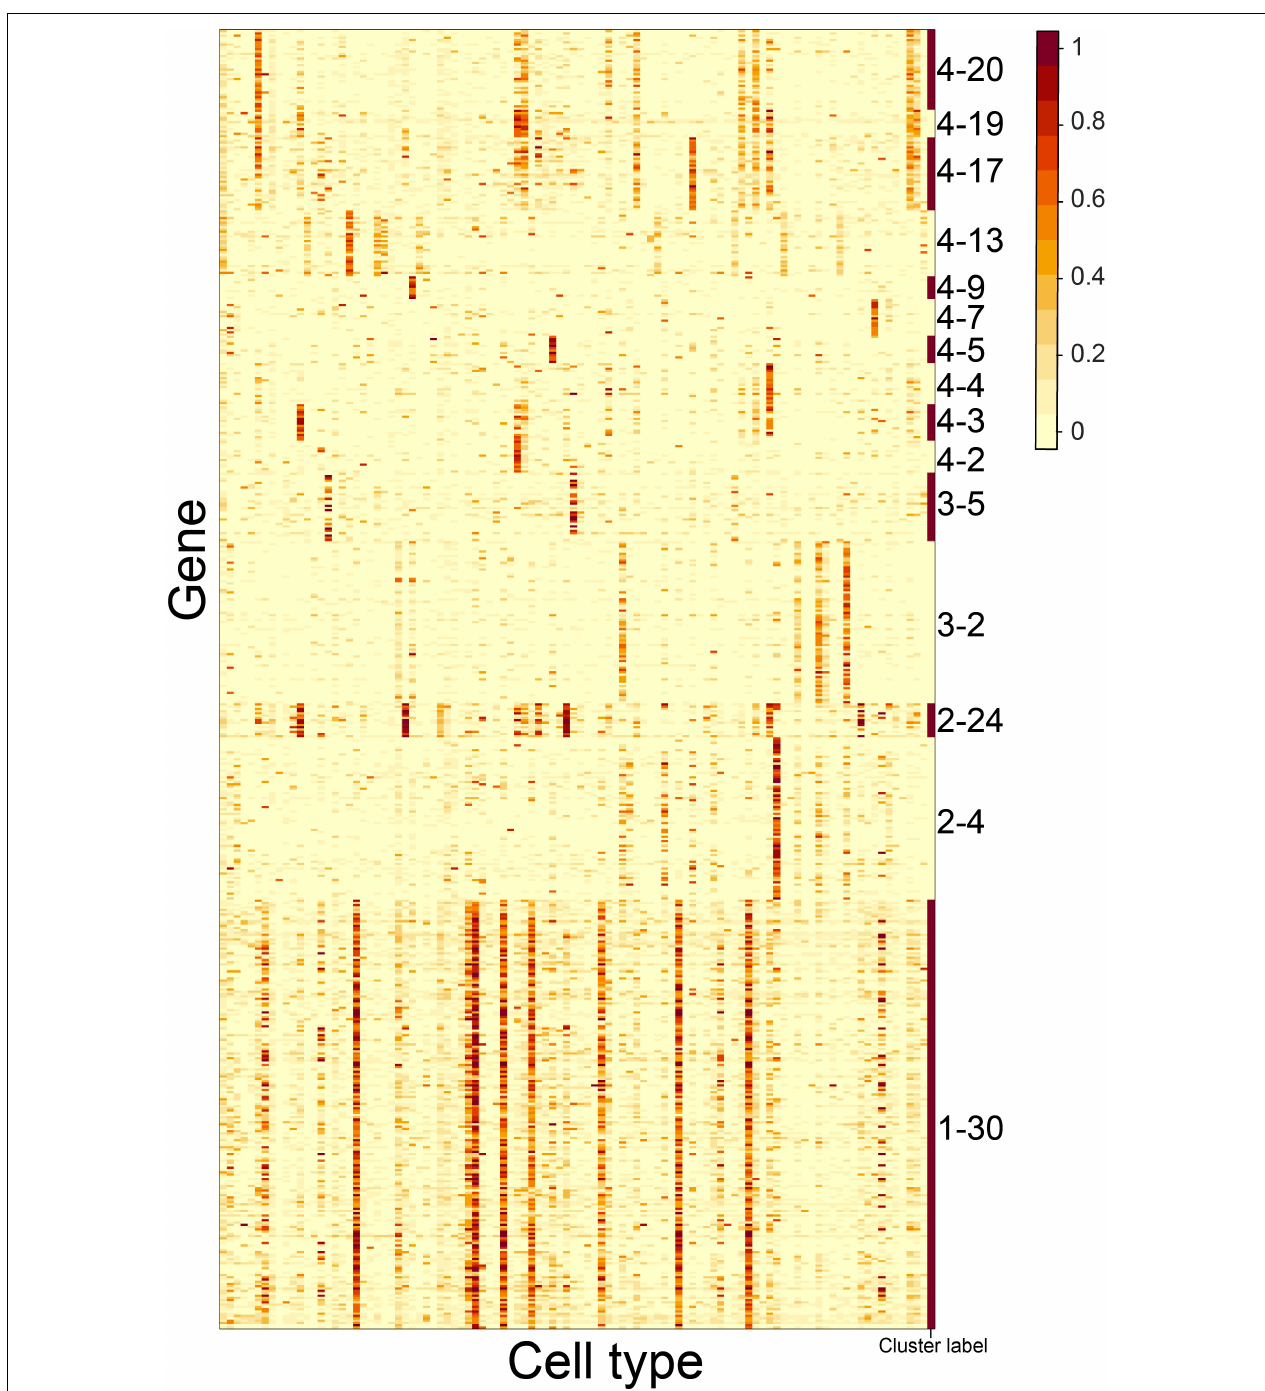
FIGURE 5 | Gene expression patterns of 15 CTS gene clusters without enriched GO terms over the 101 cell types. Genes in the heatmap were sorted by the gene clusters, and the “cluster label” distinguished the genes from different gene clusters. The names of the 101 cell types are listed in Supplementary Table 1 (“Smart_3m” column) in the same